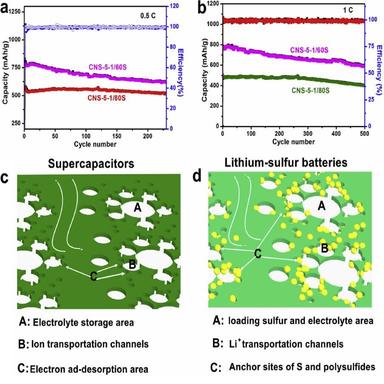
a) The cycling capacity of CNS-5-1/lS electrode with different sulfur content at a constant current density of 0.5 C. b) The cycling capacity of CNS-5-1 as electrode host materials at different sulfur content of 1 C. c) and d) The microstructure of CNS in SCs and lithium-sulfur batteries. (A colour version of this figure can be viewed online.)